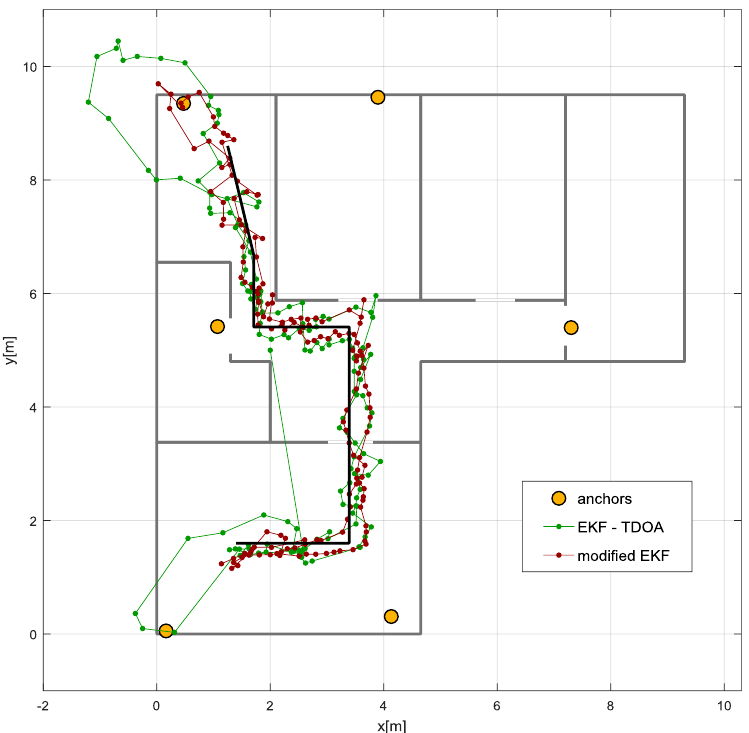
Figure 16. Tracking results obtained with Extended Kalman Filter (EKF) using Time Difference of Arrival (TDOA) values and proposed algorithm exploiting fusion of TDOA and gait parameters (modified EKF).